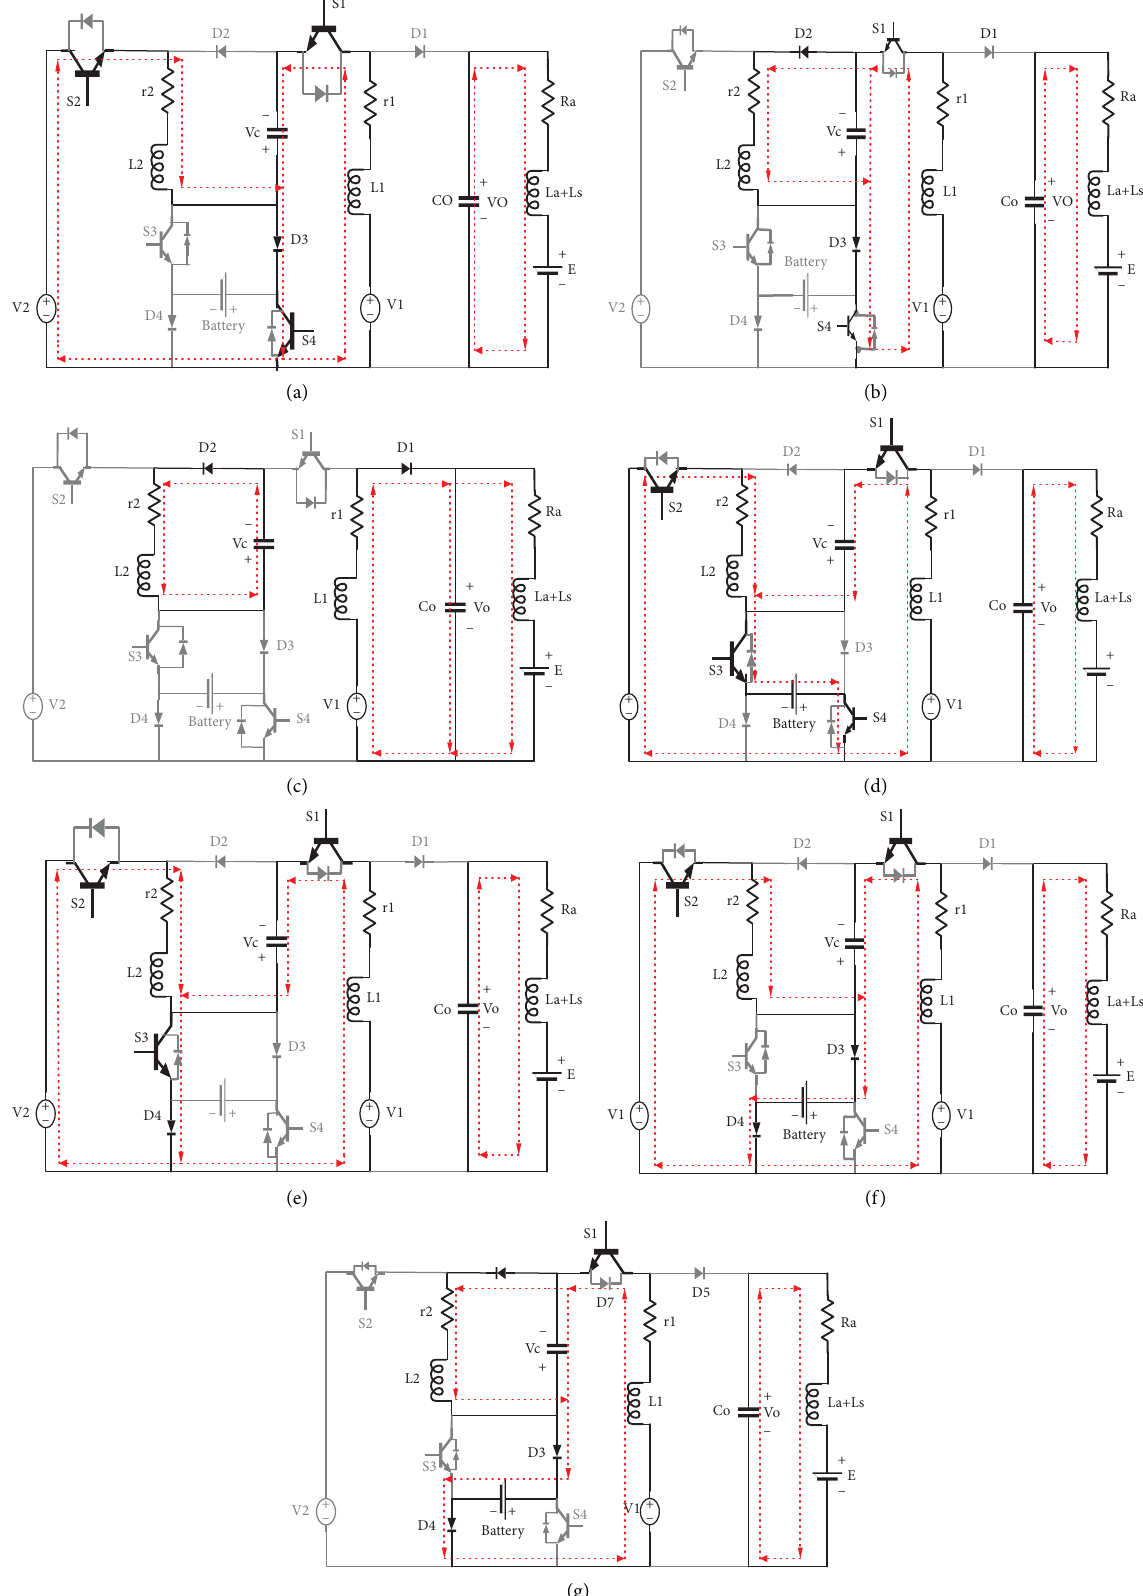
Figure 3: All operation modes of the hybrid DC-DC